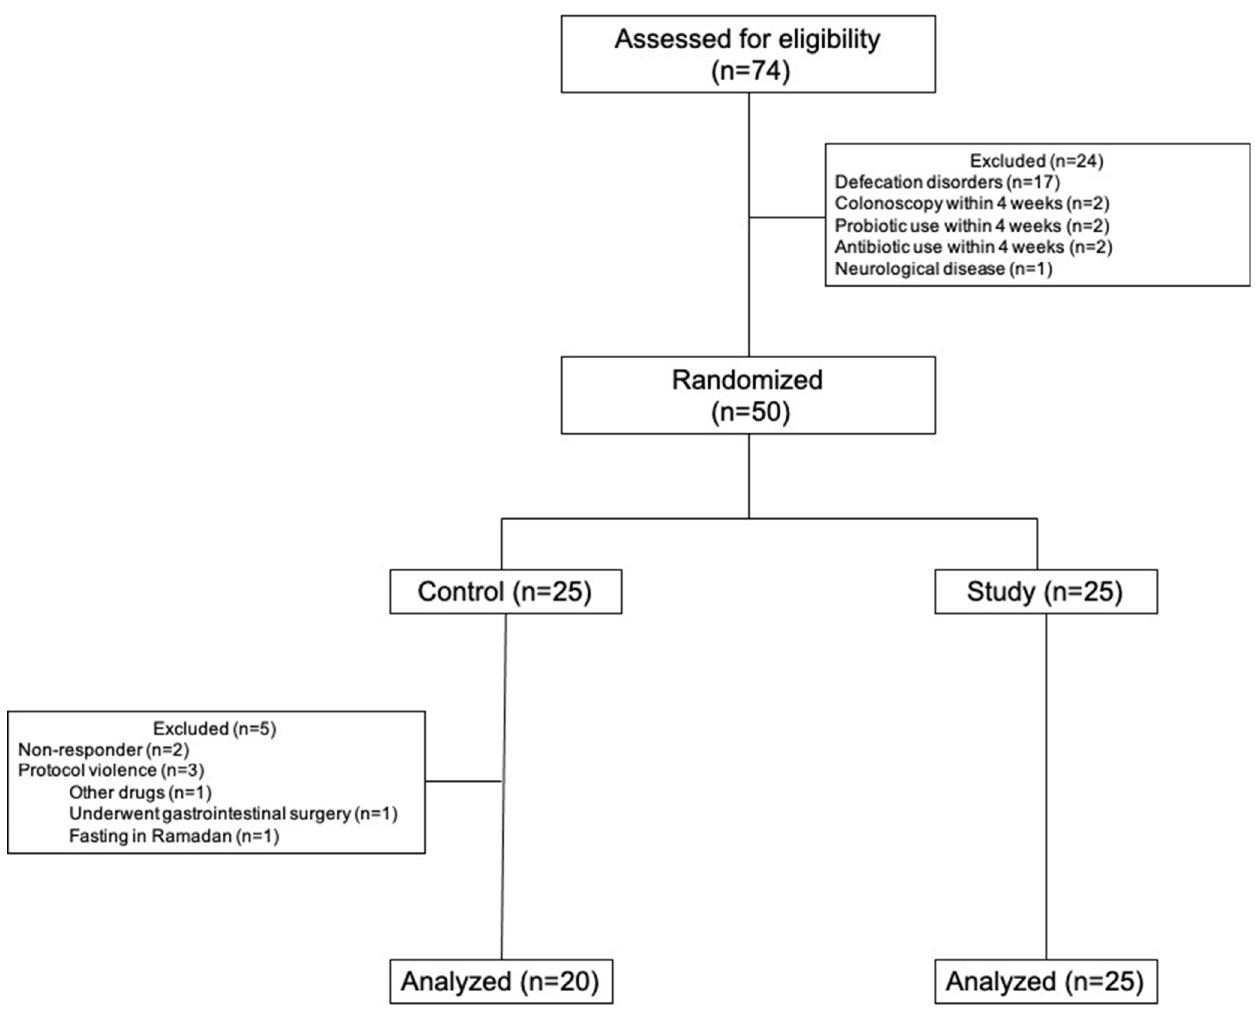
Figure 1. Flow diagram of the study. Table 1. Demographic and clinical characteristics of the patients, baseline stool frequency, and quality of life